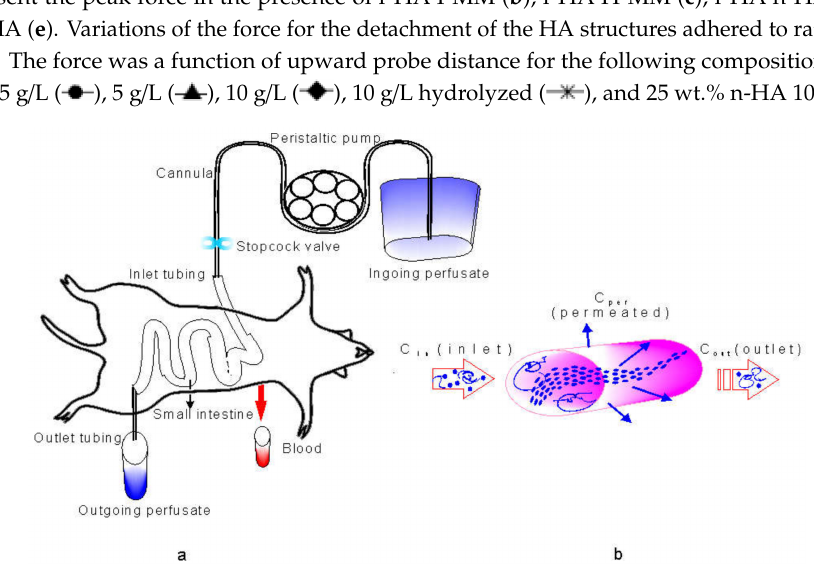
Figure 6. Scheme illustrative of the improved in situ single-pass intestinal perfusion (SPIP) method that uses the whole length of the animal intestine ( a ), and the fluxes involved in continuous intestinal perfusion ( b